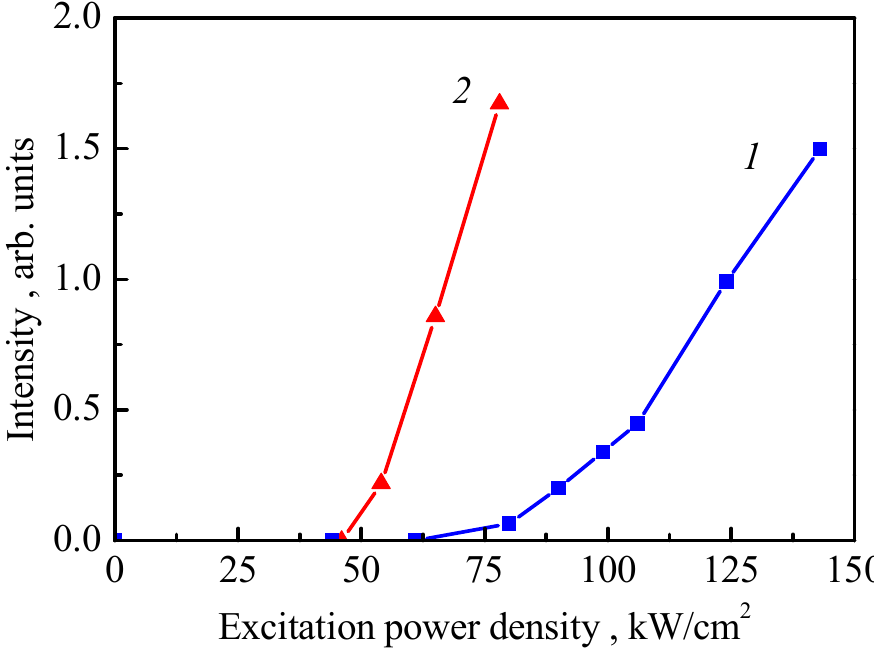
Figure 3. Dependence of the emission intensity of the optically pumped laser structures on the excitation power density for the samples A (1) and B (2).